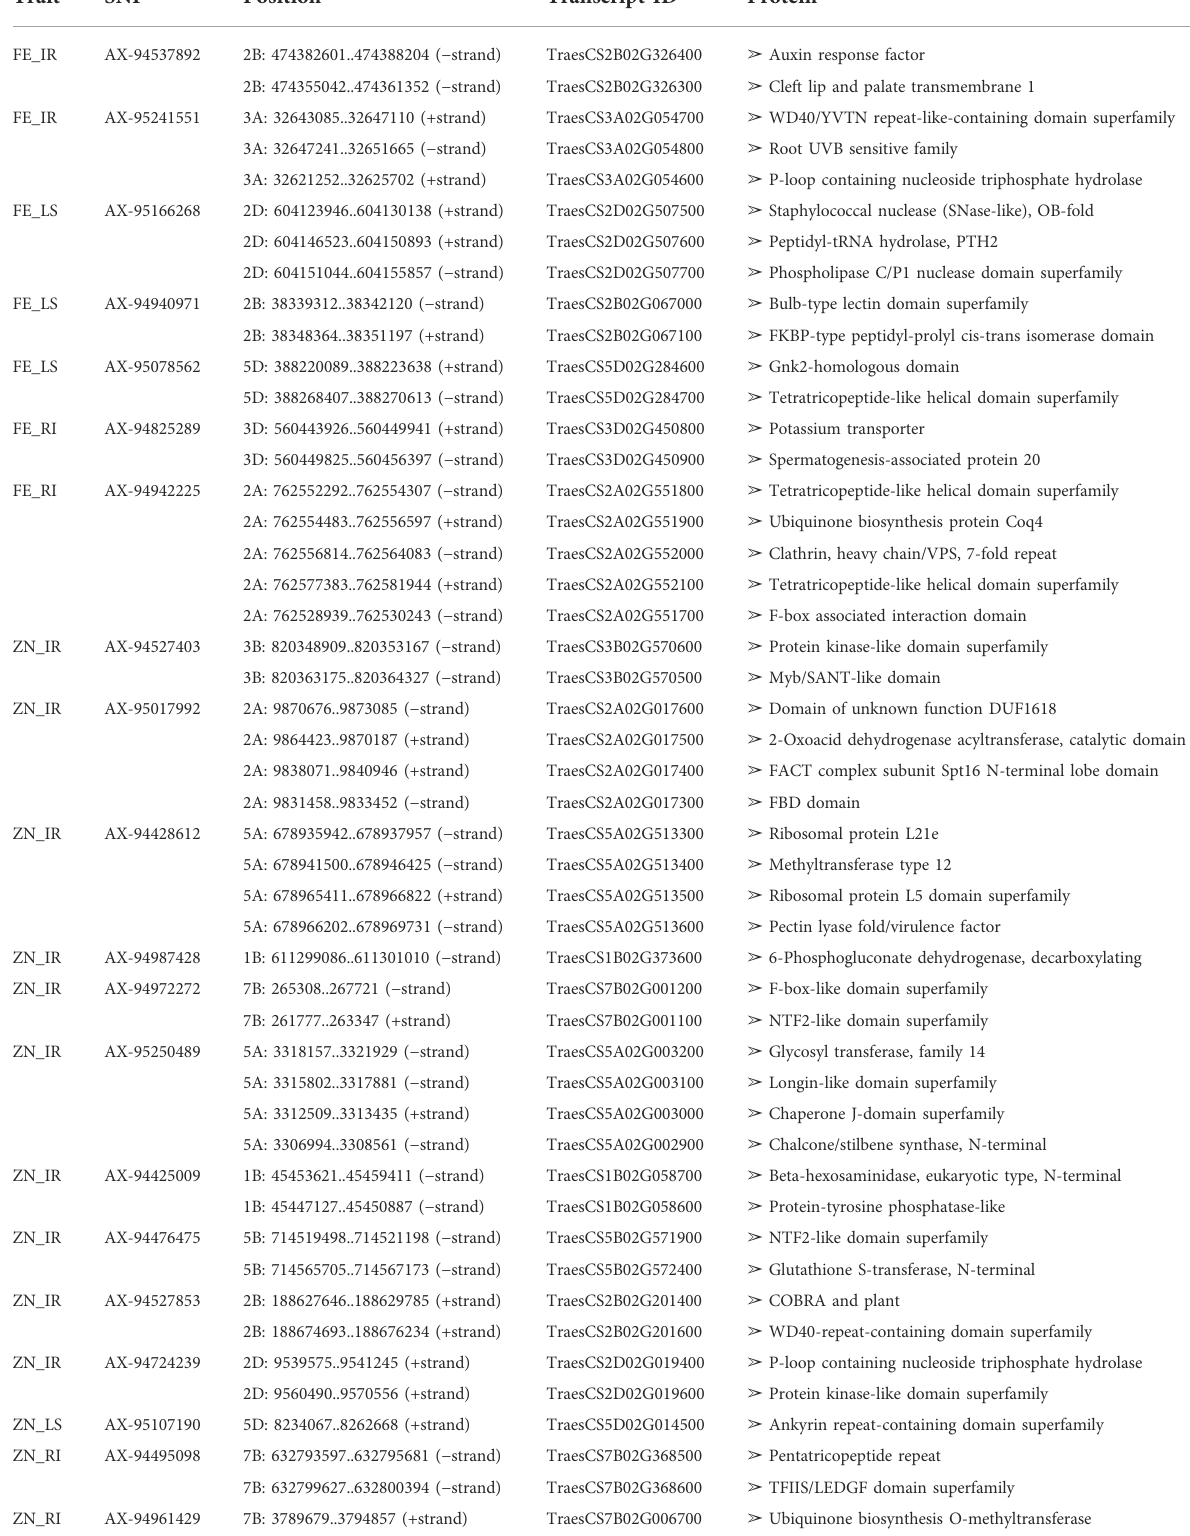
TABLE 3 Putative candidate genes in the 100-kb region of the linked marker with the protein produced from them.